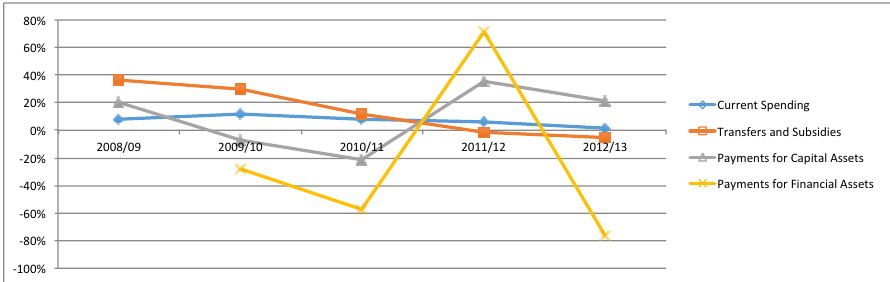
FIGURE 4: Real growth in provincial expenditures per line item - Post-crisis (%) Source: National Treasury